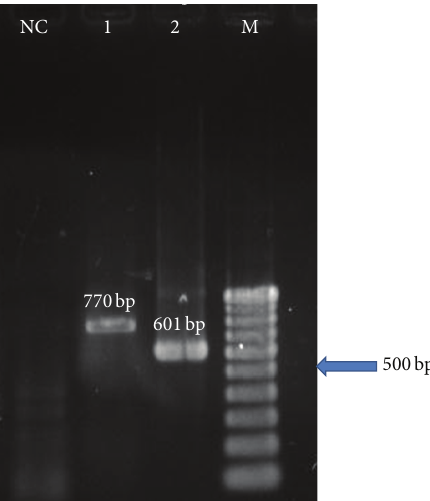
Figure 1: Nested RT-PCR assay used to detect FeLV U3LTR-gag sequence from naturally infected cats in Malaysia. The outer PCR reaction was performed using primer pair U3-F(1) and G-R(1) and amplified 770 bp (lane 1) whilst inner PCR reaction was performed using primer pair U3-F(2) and G-R(2) and amplified 601bp (lane 2). Lane NC: negative control, lane M:100bp DNA marker (iDNA, Malaysia).